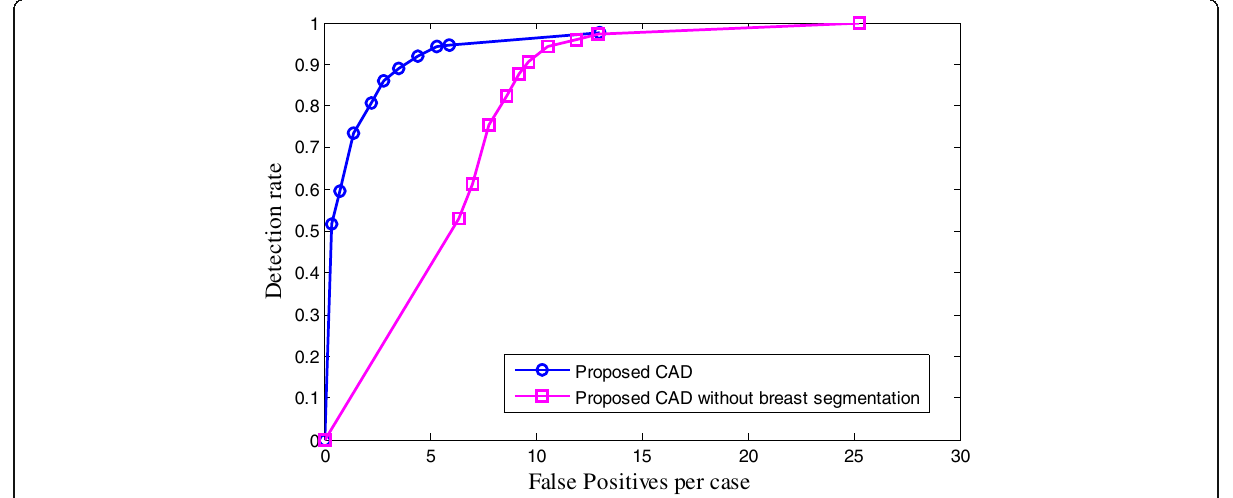
Fig. 8 Comparison of the FROC curves obtained from the proposed CAD with and without breast segmentation process